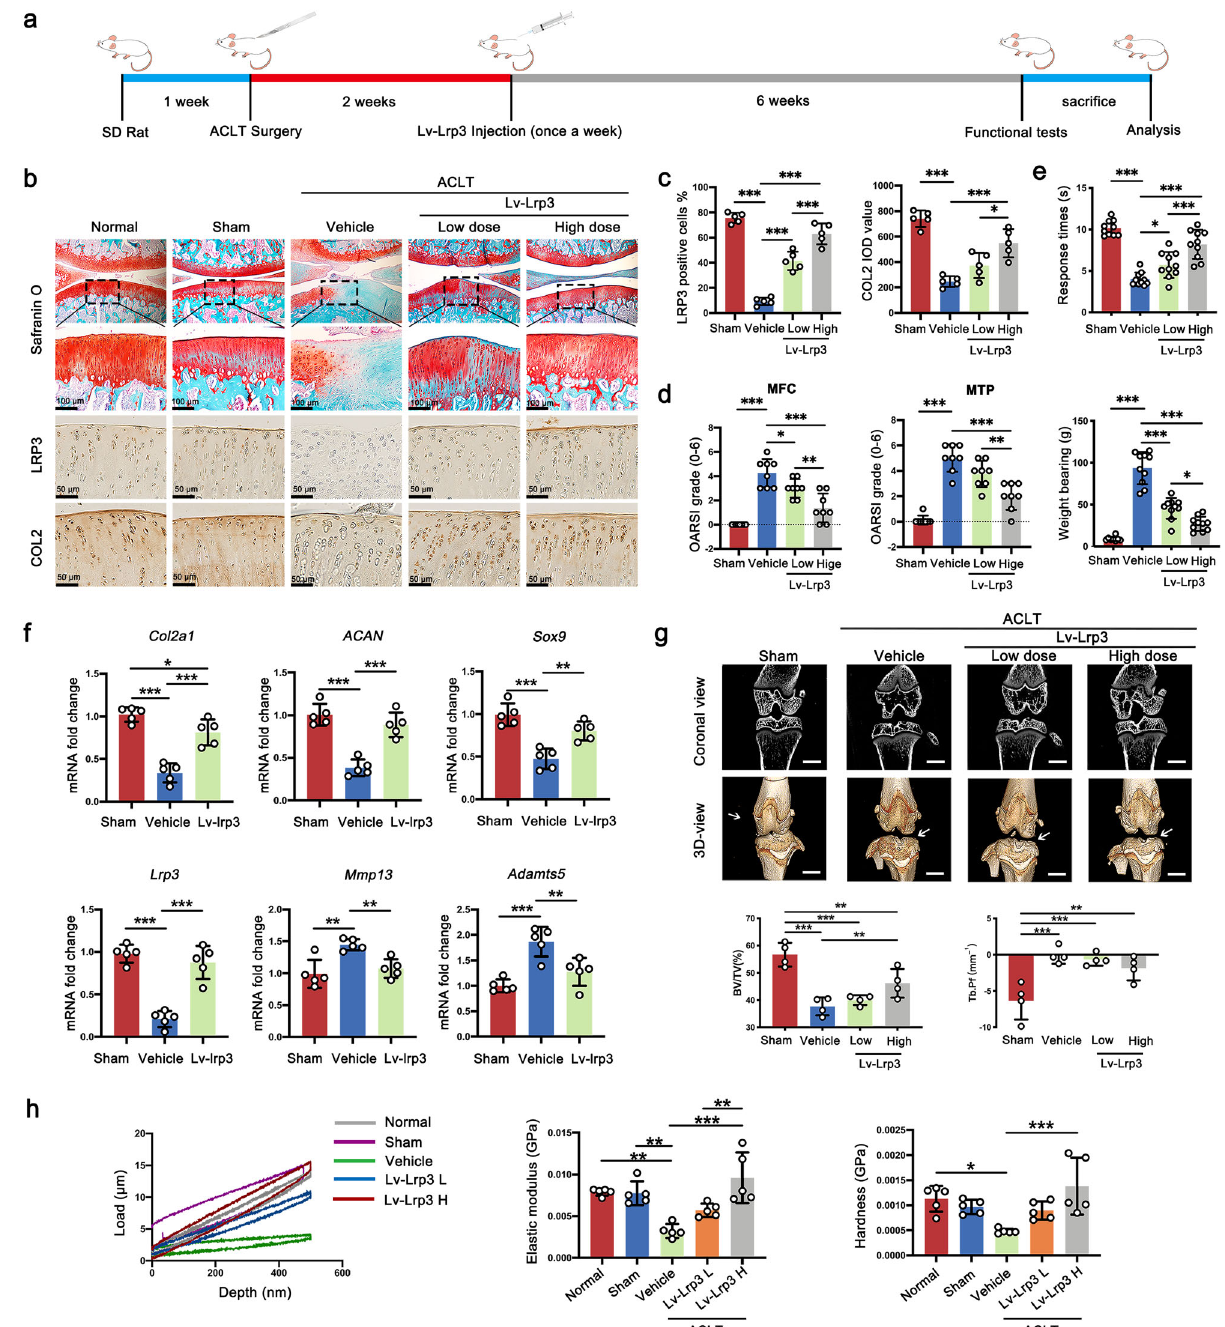
Fig. 5 | Overexpression of LRP3 in cartilage attenuates OA progression. a Scheme of the OA treatment with intra-articular injection of Lv-Lrp3 in rats. b Representative images of safranin O-fast green, COLII, and LRP3 IHC staining of Normal, Sham, Vehicle, and Lv-Lrp3 treatment rats at 6w, insets indicate the regionsshownintheenlargedimages( n =8). c Quanti fi cationofLRP3-positivecells andIODvalueforCOLIIinNormal,Sham,Vehicle,andLv-Lrp3treatmentrats( n =5, one-way ANOVA). d The corresponding OARSI scores of Normal, Sham, Vehicle, and Lv-Lrp3 treatment rats at 6w ( n =8, one-way ANOVA). e The pain response of rats was analyzed using a hot plate and weight-bearing tests ( n =10). f Quanti fi cation of mRNAlevels for Col2a1 , ACAN , Sox9 , Lrp3 , Mmp13 , and Adamts5